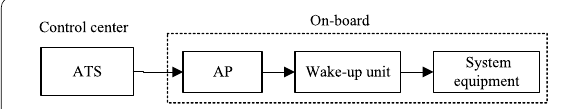
Figure 6 Basic flow of the wake-up